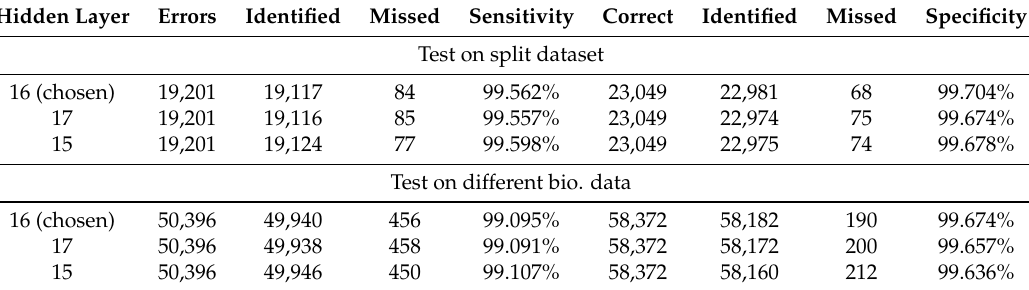
Table 3. Change of accuracy with different ANN hidden neuron